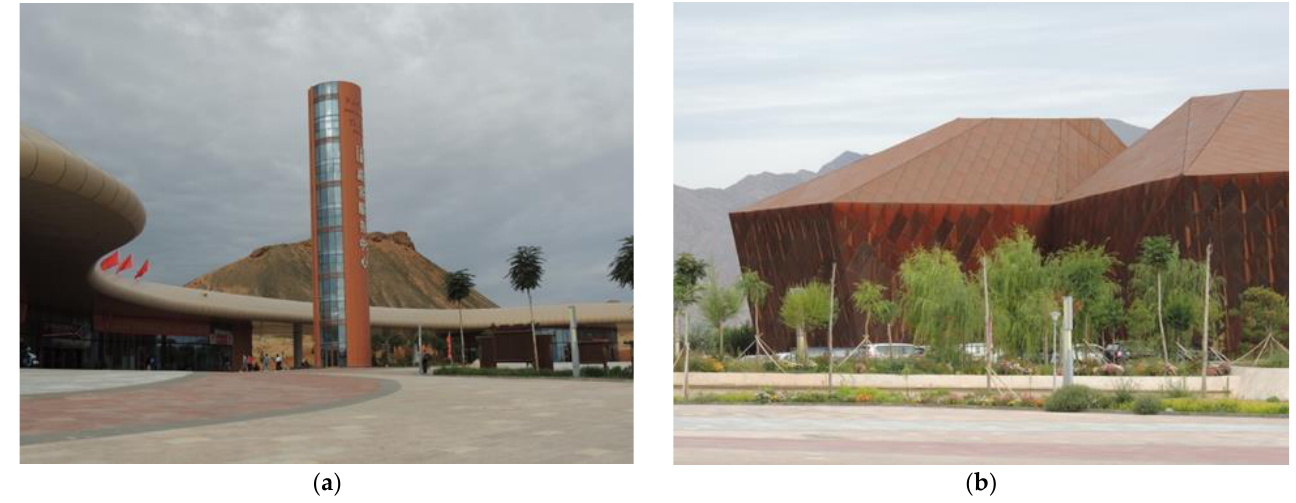
Figure 6. ( a ) Visitor centre/ticket office of the Zhangye Danxia Geopark (credit Loredana Luvidi); ( b ) the museum of the Zhangye Danxia Geopark (credit Loredana Luvidi) .